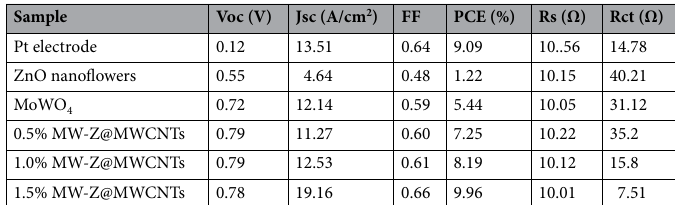
Table 1. Photovoltaic parameters of DSSCs with different